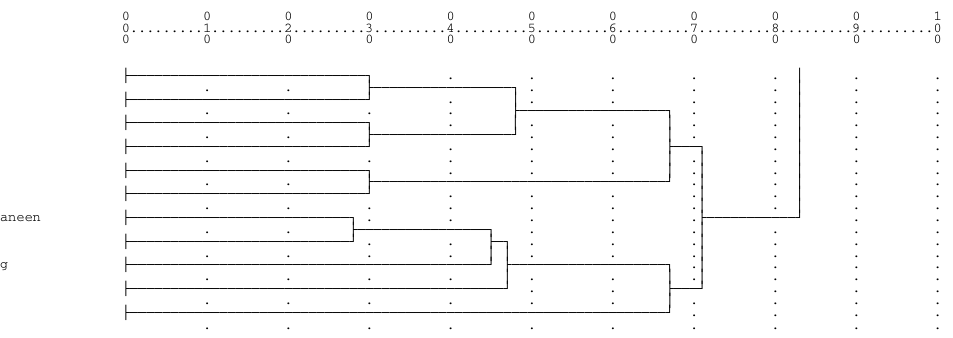
Figure 7 : Dendogram of the last 11 regions in the Northern region Figure 7: Dendrogram of the last eleven regions in the Northern